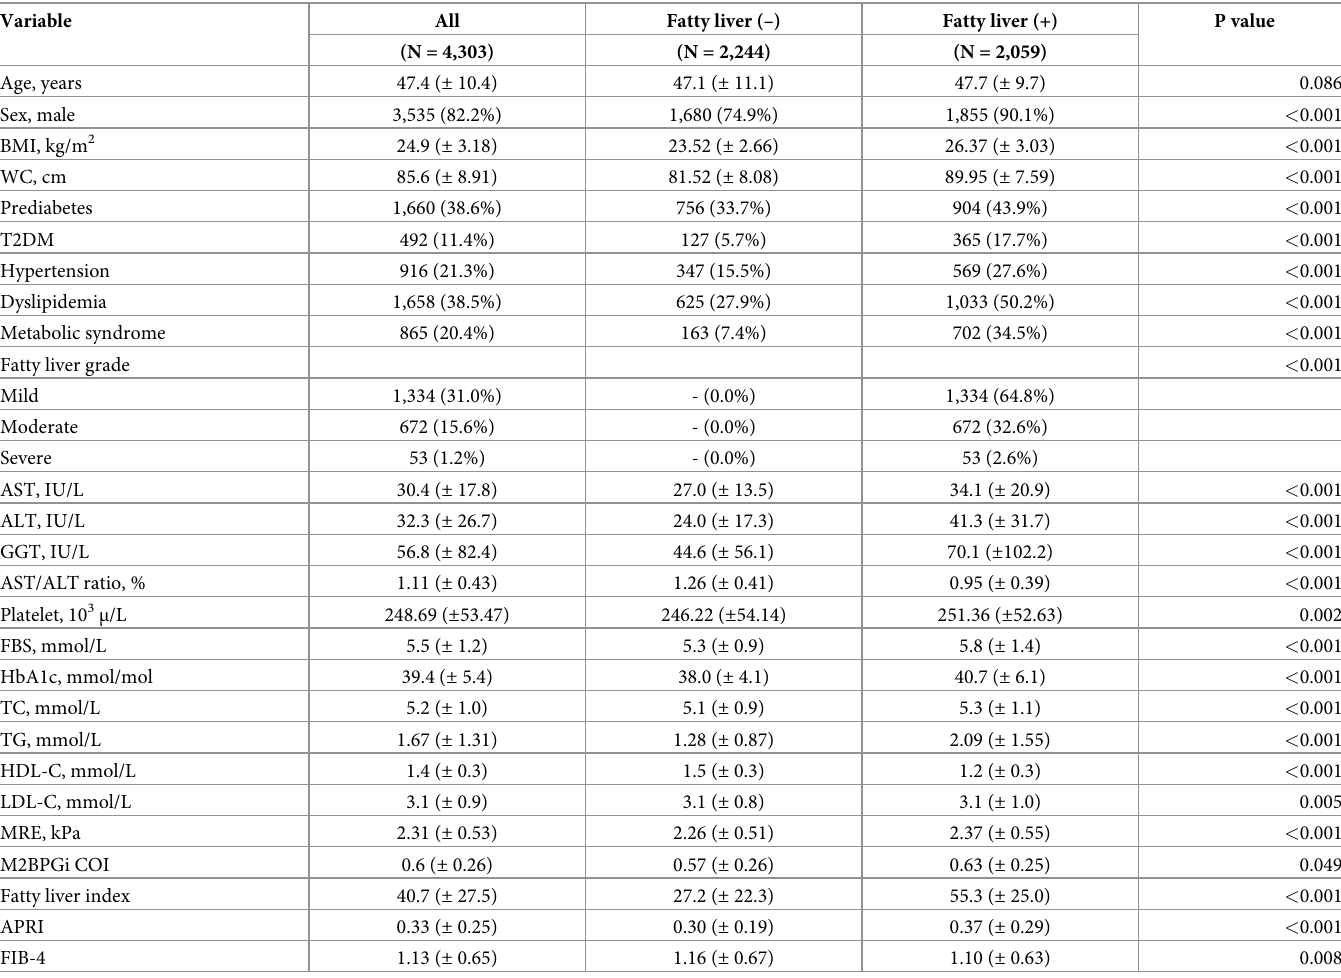
Table 1. Characteristics of the study